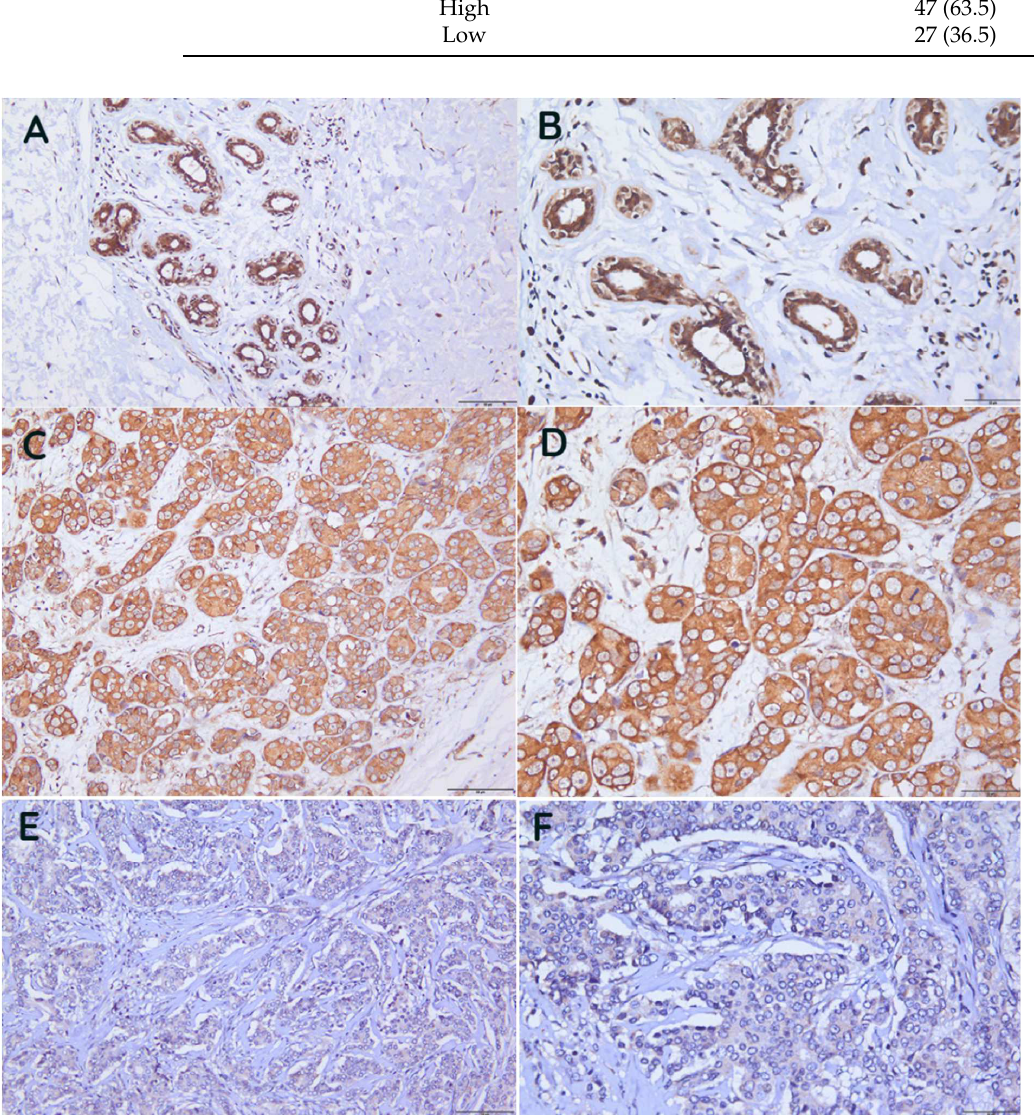
Figure 4. GLYATL-1 expression in normal breast duct, breast carcinoma in situ, and invasive breast carcinoma tissues. GLYATL-1 expression in ( A , B ) normal breast duct tissues. ( C , D ) Breast carcinoma in situ. ( E , F ) Invasive breast carcinoma tissues. ( A , C , E ) ×20 µm. ( B , D , F ) ×40 µm.